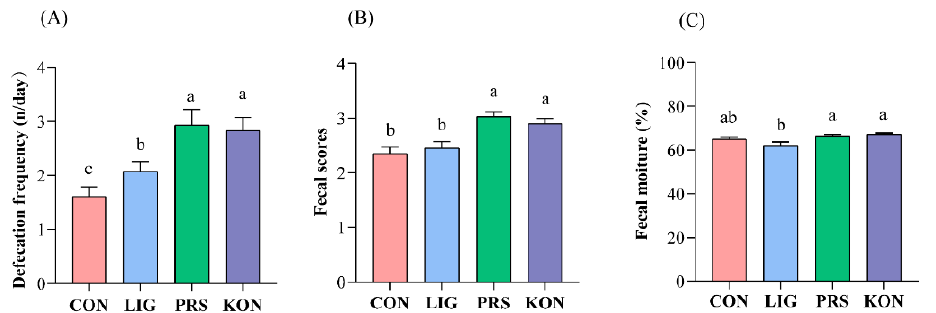
Figure 1. Effects of different fiber sources on the defecation frequency ( A ), fecal consistency score ( B ), and fecal moisture of sows ( C ) ( n = 20). CON, control; LIG, lignocellulose; PRS, resistant starch; KON, konjaku flour. Differences in the superscript letters for the peer data indicate that the difference is significant ( p < 0.05).